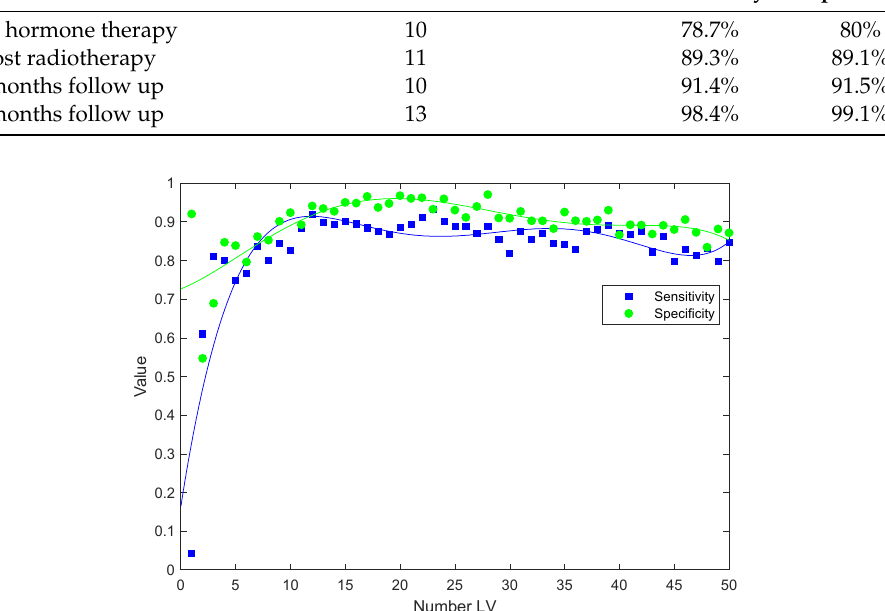
Figure 5. Typical cross-validated sensitivity and specificity for a PLS-DA model developed on FTIR spectra of plasma from patients at baseline and post radiotherapy with increase in the number of latent variables included in the model (LVs).